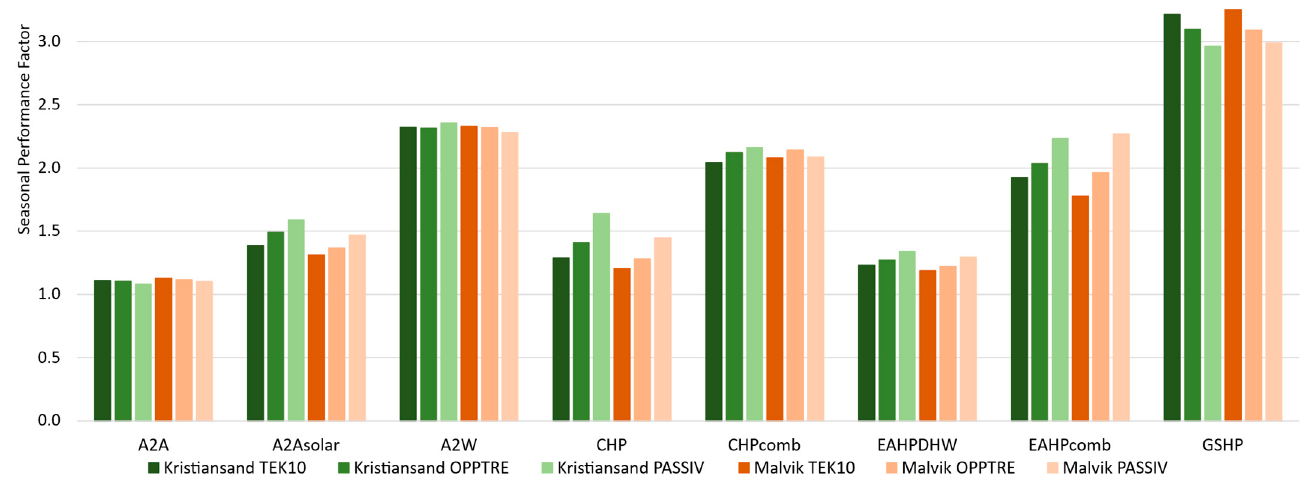
Figure 5. Seasonal performance factor for heat pump systems in both houses.